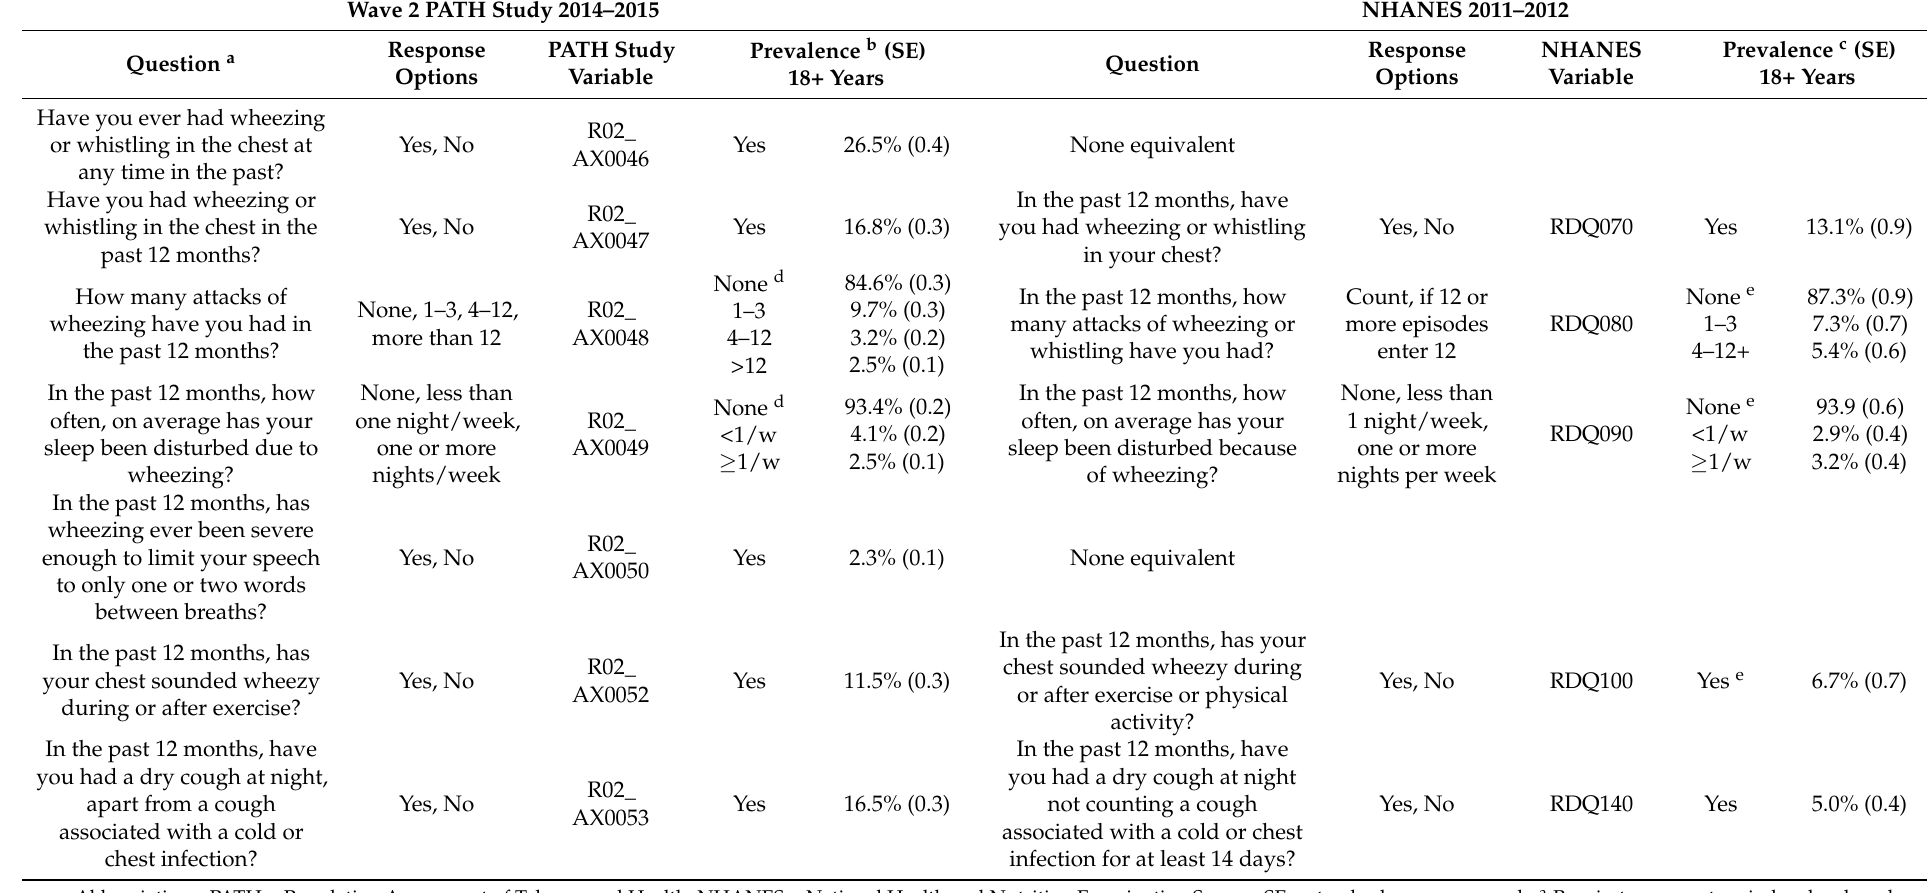
Table 1. Respiratory symptom questions in the Wave 2 (2014–2015) PATH Study interview, along with similar questions in the NHANES 2011–2012